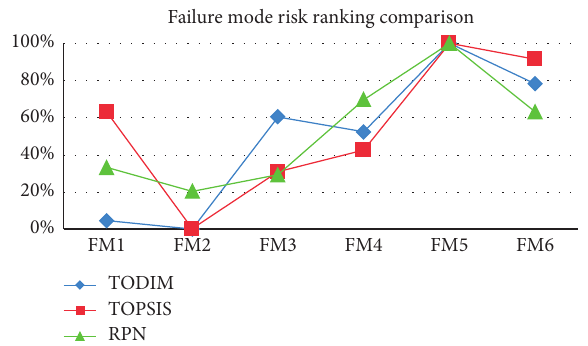
Figure 5: Failure mode risk ranking